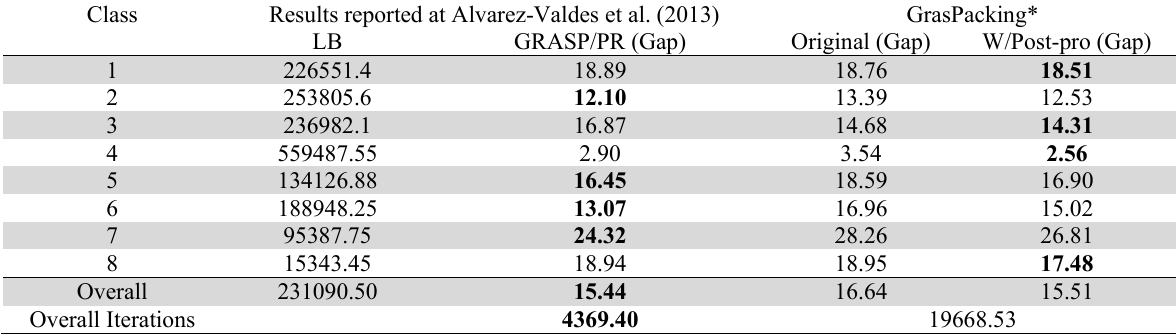
Results of the instances referring to the MBSBPP compared against the GRASP/PR algorithm of Alvarez-Valdes et al. (2013)